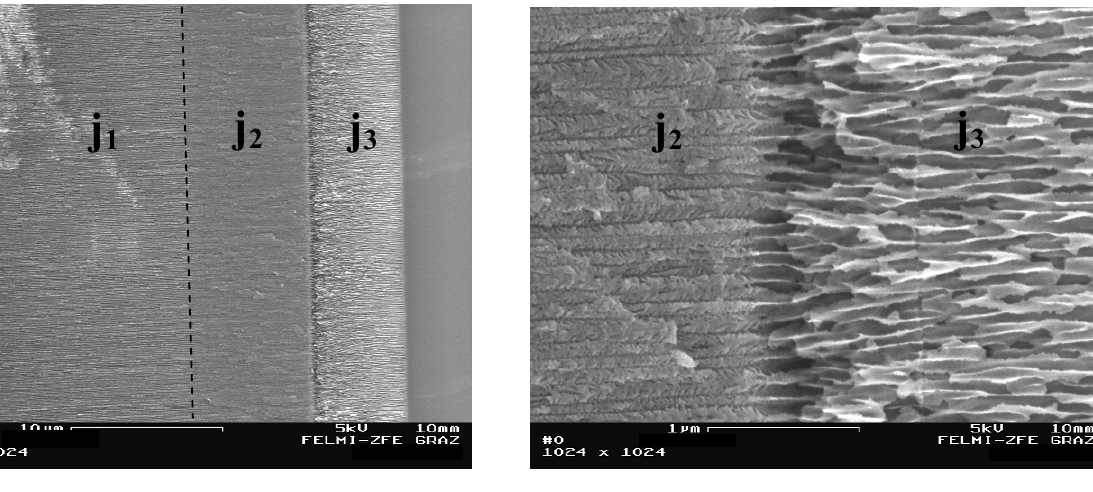
= 75 mA/cm 2 , j = 50 mA/cm 2 , 1 2